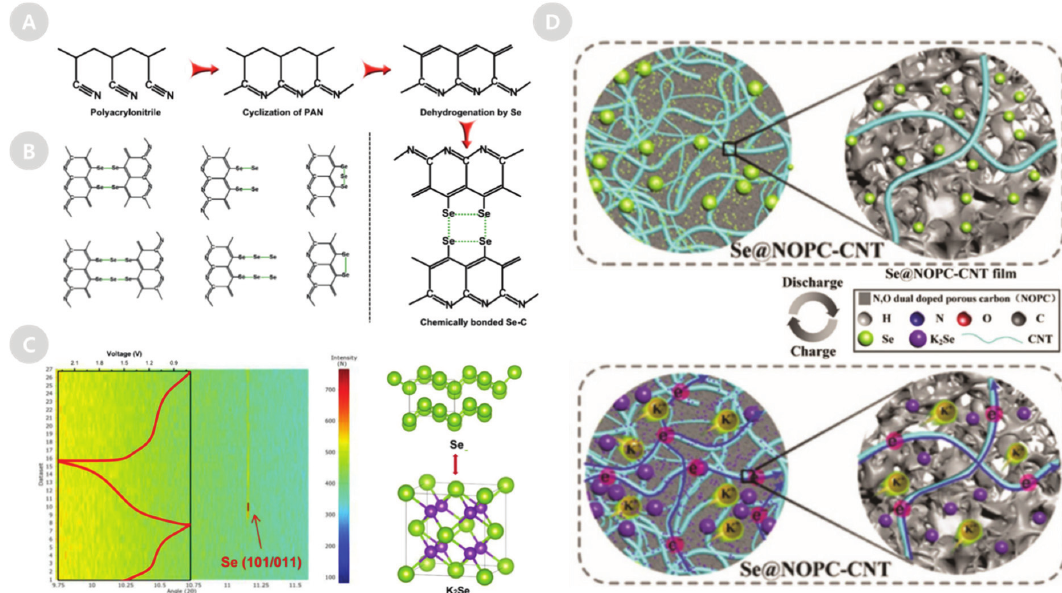
Figure 5. ( A ) Reaction mechanism and changes in the molecular structure during the carbonization of PAN and selenization between Se and c-PAN. Figure adapted from Reference [11]. ( B ) Possible molecular structures of the as-prepared chemically bonded Se/C composite. Figure adapted from Reference [11]. ( C ) In-situ synchrotron X-ray diffraction(XRD) spectra with corresponding voltage profile and structural representations of Se and K 2 Se phases during discharge–charge process. Figure adapted from Reference [11]. ( D ) Schematic of the K-ion and electron transportation process in the nitrogen and oxygen dual-doped Se@NOPC-CNT electrode when used in K–Se batteries. Figure adapted from Reference